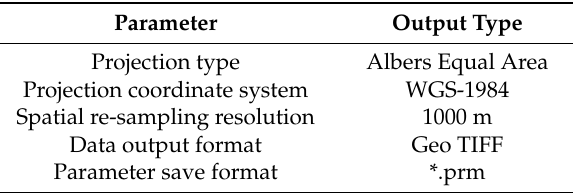
Table 2. The MRT parameter and output type